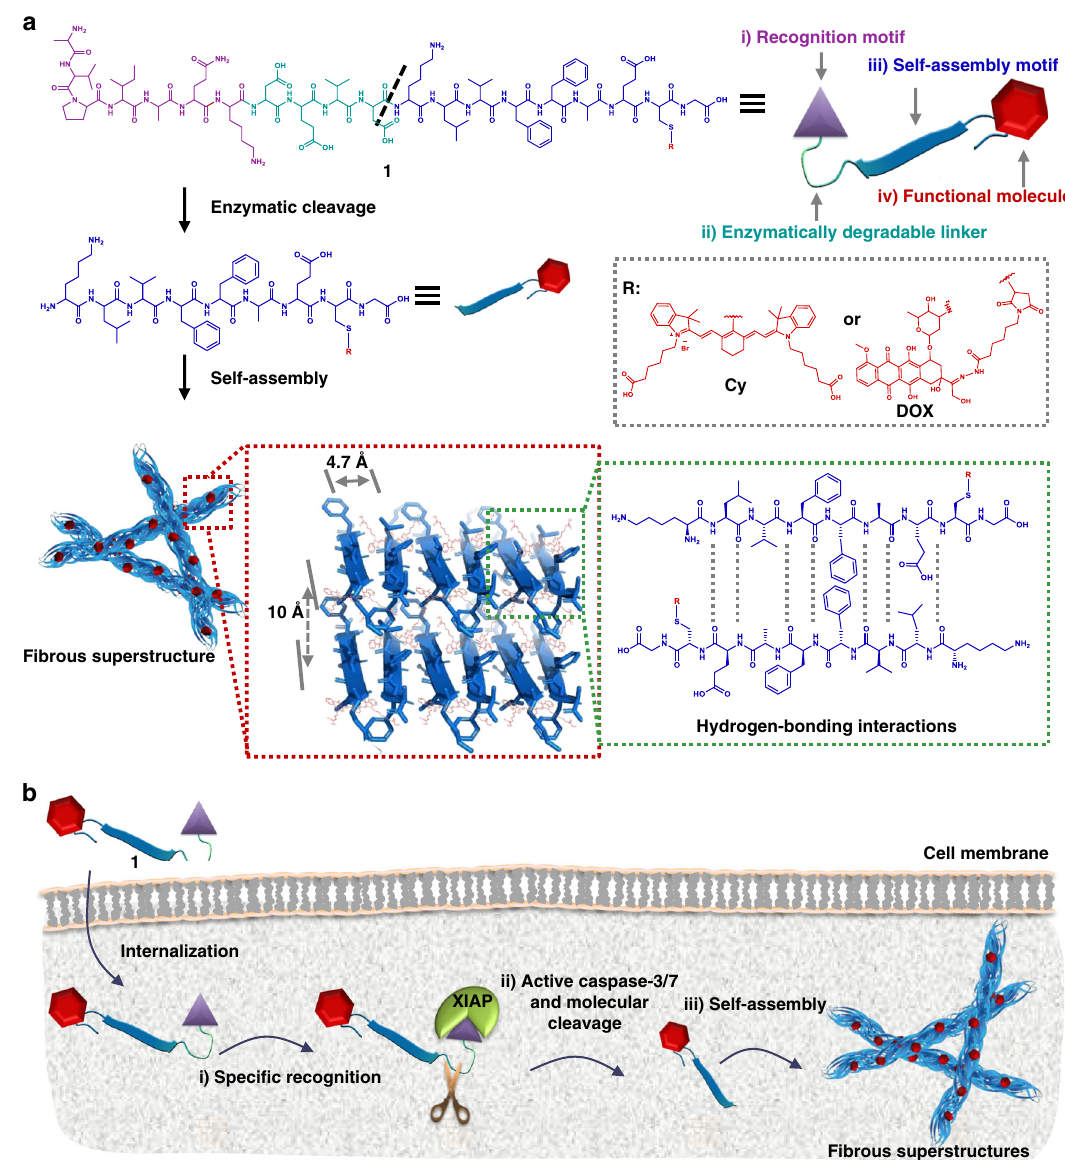
Fig. 1 Illustration of the tumour-selective cascade activatable self-detained system (TCASS) and its molecular design. a the modularized peptide-based molecules consisted of four sections: (i) recognition motif: AVPIAQK was the binding motif; (ii) DEVD was the enzymatically degradable linker; (iii) KLVFFAECG was the self-assembly motif; and (iv) cyanine dye (Cy) or doxorubicin (DOX) was functional molecule. b the mechanism of the speci fi c recognition, molecular cleavage and in situ self-assembly of molecule 1. First, molecule 1 was speci fi cally recognized by X-linked inhibitor of apoptosis protein (XIAP); then the caspase-3/7, activated by the recognition process, cleaved the molecules; further, the cleaved molecules rapidly self-assembled in situ and formed fi brous β -sheet superstructures; fi nally, the β -sheet nanostructures signi fi cantly enhanced the accumulation and retention of functional molecule in tumour